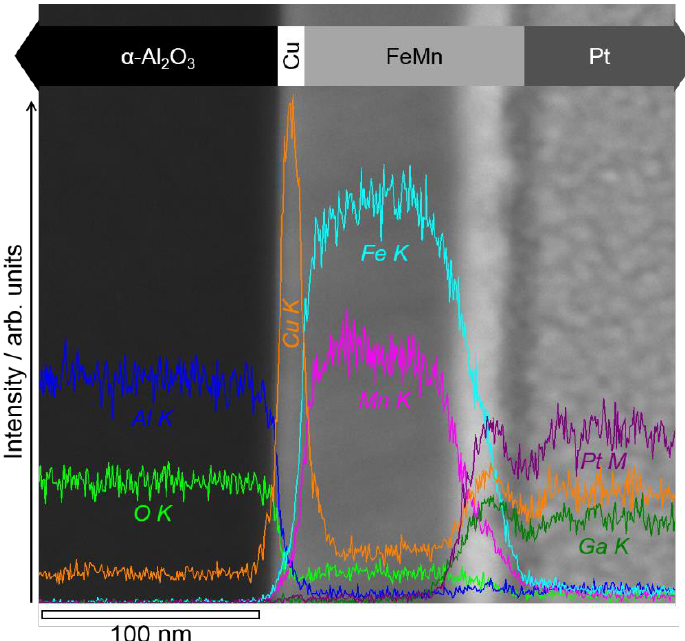
Figure 3. Scanning transmission electron microscopy (STEM) high angle annular dark field (HAADF) image of the layer system α -Al 2 O 3 /Cu/Fe 0.58 Mn 0.42 with corresponding energy dispersive X-ray (EDX) line scan including the Al K, O K, Cu K, Fe K, Mn K, Pt M and Ga K intensities. The intensity signal is not corrected for peak overlapping.